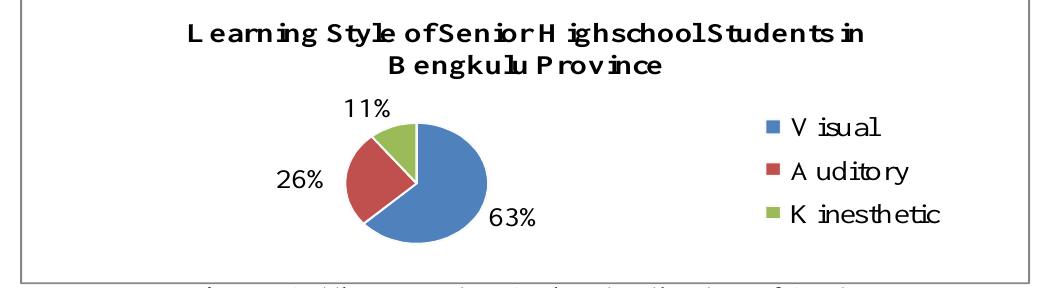
Figure 2: The Learning Style Distribution of Senior